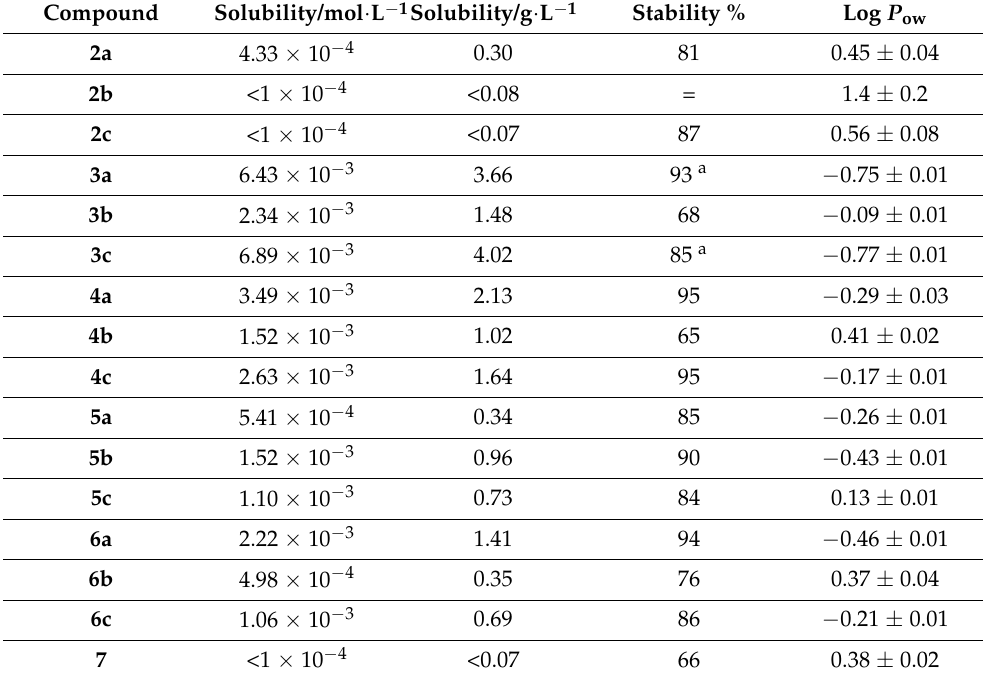
Table 3. Solubility of diiron complexes in D 2 O at 21 ◦ C ( 1 H NMR, Me 2 SO 2 internal standard), residual % in DMSO-d 6 /D 2 O (2:1 v / v ) after 72 h at 37 ◦ C ( 1 H NMR, Me 2 SO 2 internal standard) and octanol–water partition coefficients at 21 ◦ C (Log P ow , UV–Vis). a Stability evaluated in neat D 2